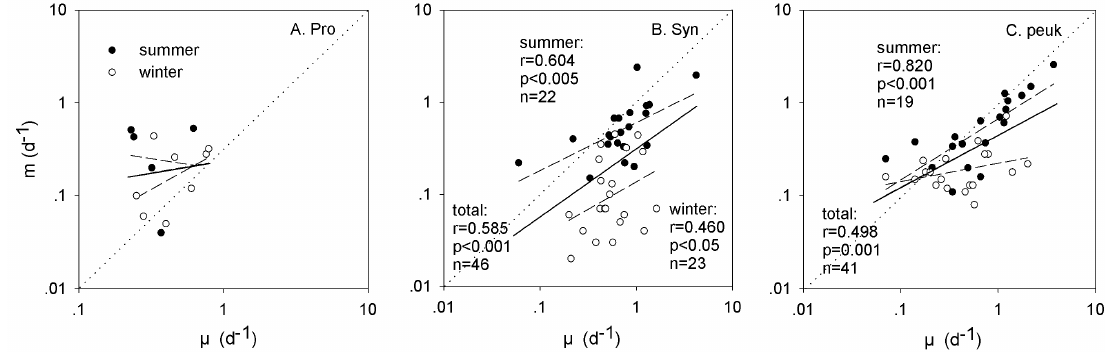
Fig. 7. Relationship between grazing mortality ( m ) and growth rate ( µ ) for (A) Prochlorococcus (Pro), (B) Synechococcus (Syn) and (C) picoeukaryotes (Peuk). The dotted line is a 1:1 line for the two parameters. The short dash line and solid line are the regression curves for each season separately and two seasons together, respectively. r , p and n are correlation coefficients, statistical significance levels and number of data points.